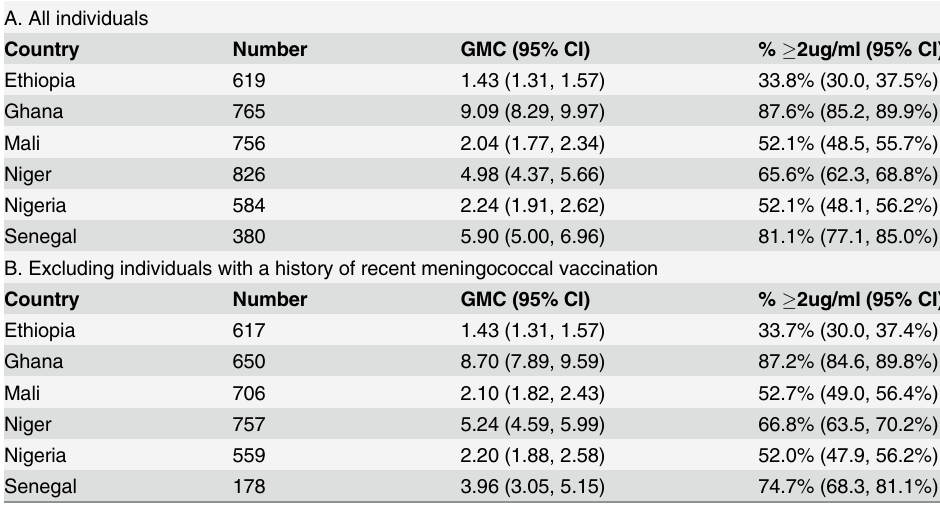
Table 2. Geometric mean meningococcal serogroup A IgG antibody concentrations and seropreva- lence by